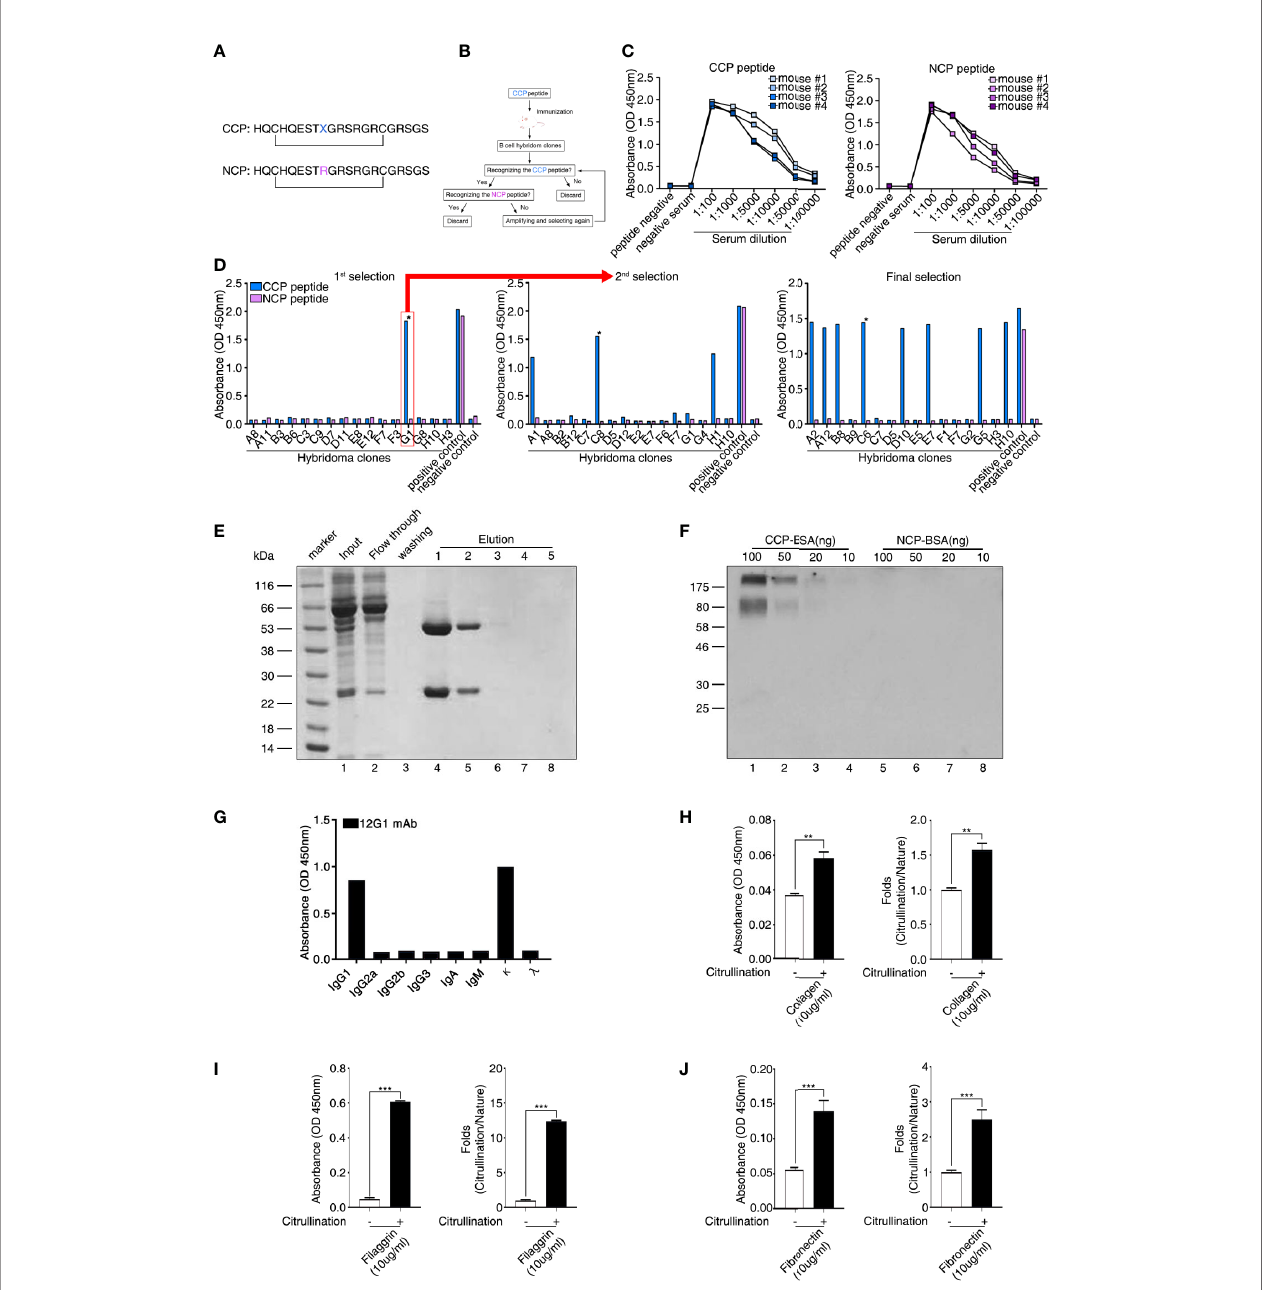
FIGURE 1 | Generation of a cyclic citrullinated peptide (CCP) – speci fi c monoclonal antibody (mAb). (A) Sequences of the two synthetic peptides used as antigens. Both peptides shared the same sequence, except that the CCP was generated by replacing an arginine residue with a citrulline residue (X = citrulline). The bar indicates a disul fi de bond between the two cysteines, which generates a circular peptide. (B) Schematic diagram showing the strategy for selecting hybridoma clones. Hybridoma clones that secreted antibodies speci fi c to CCP were obtained by repeated selection. (C) Selection of mice showing seroreactivity against the CCP. After the fi rst injection of the CCP, the binding reactivity to the CCP and the cyclic arginine peptide (NCP) was examined using ELISA (serum samples diluted 1:100 to 1:100000). (D) ELISA of fused hybridoma clones that secreted mAbs to the CCP. After fusion, hybridoma clones secreting anti-CCP antibodies speci fi c for the CCP but not the NCP were selected. Clones reactive to the CCP were isolated and evaluated repeatedly until a single clone secreting high-reactivity anti-CCP antibodies was selected. (E) The 12G1 mAb was puri fi ed from the hybridoma culture supernatant using a Protein G agarose column. After the supernatant (input) was loaded onto the column, bound 12G1 mAb was eluted in the elution buffer (elution). The puri fi ed antibody was con fi rmed by SDS-PAGE and Coomassie brilliant blue staining. (F) The speci fi city of the 12G1 mAb for the CCP was examined by Western blotting. CCP – BSA and NCP – BSA conjugates were run in an SDS-PAGE gel and then immunoblotted with the 12G1 mAb. (G) mAb 12G1 immunoglobulin isotyping assay (absorbance of positive response ≥ 0.2). (H – J) The 12G1 mAb- based ELISA system effectively detected citrullinated collagen (H) , citrullinated fi laggrin (I) , and citrullinated fi bronectin (J) . *P < 0.05; **P < 0.01; ***P <